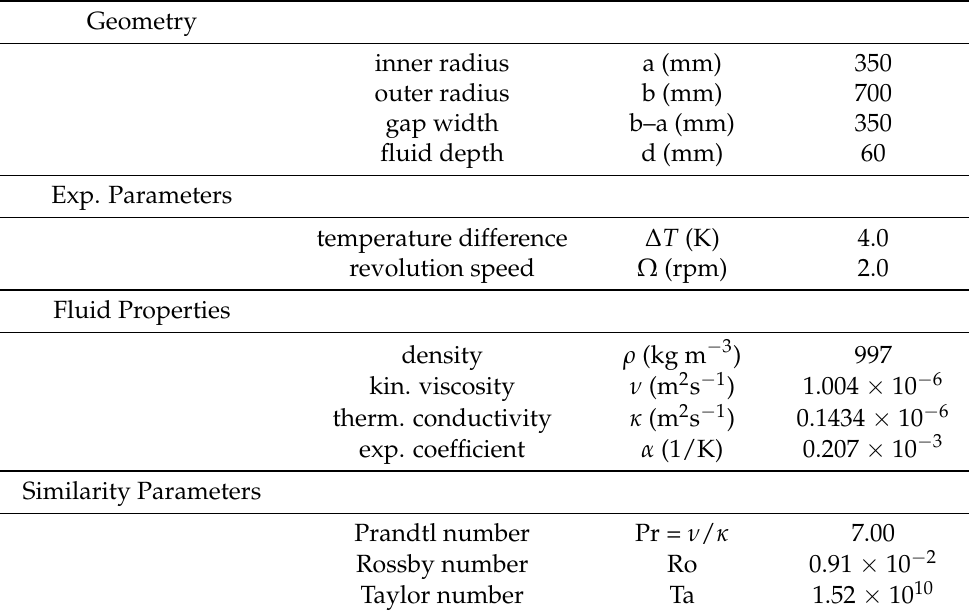
Figure 1. Sketch of the experiment ( left ) and a picture taken in the lab ( right ). See also [6,7]. Table 1. Parameters of the laboratory experiment. See also Figure 1